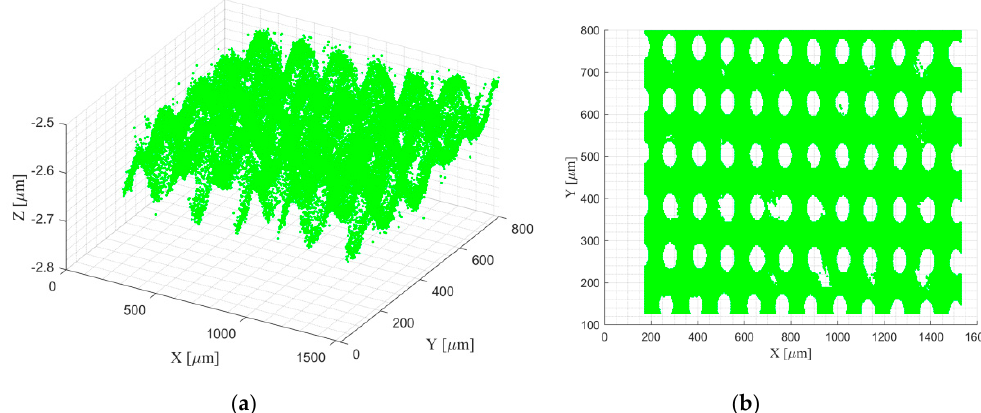
Figure 7. The separated flat plane of the rotated surface: ( a ) 3D view; ( b ) view from top down.